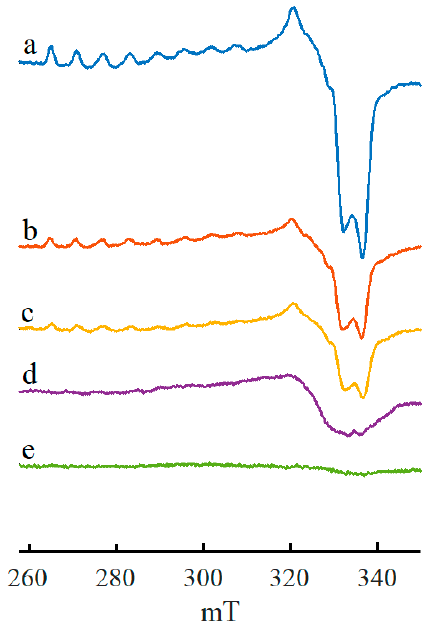
Figure 5. EPR spectra of the catalytic system formed on the basis of AlEt 3 in an argon atmosphere, (a) Co(acac) 2 , (b) Co(acac) 2 · 0.5H 2 O, (c) Co(acac) 2 · 3.0H 2 O, (d) Co(acac) 2 –AlEt 2 (OEt) and (e) Co(acac) 2 –AlEt 3 –3 n -BuOH. Spectra were obtained under identical conditions. Spectra (a,b) were